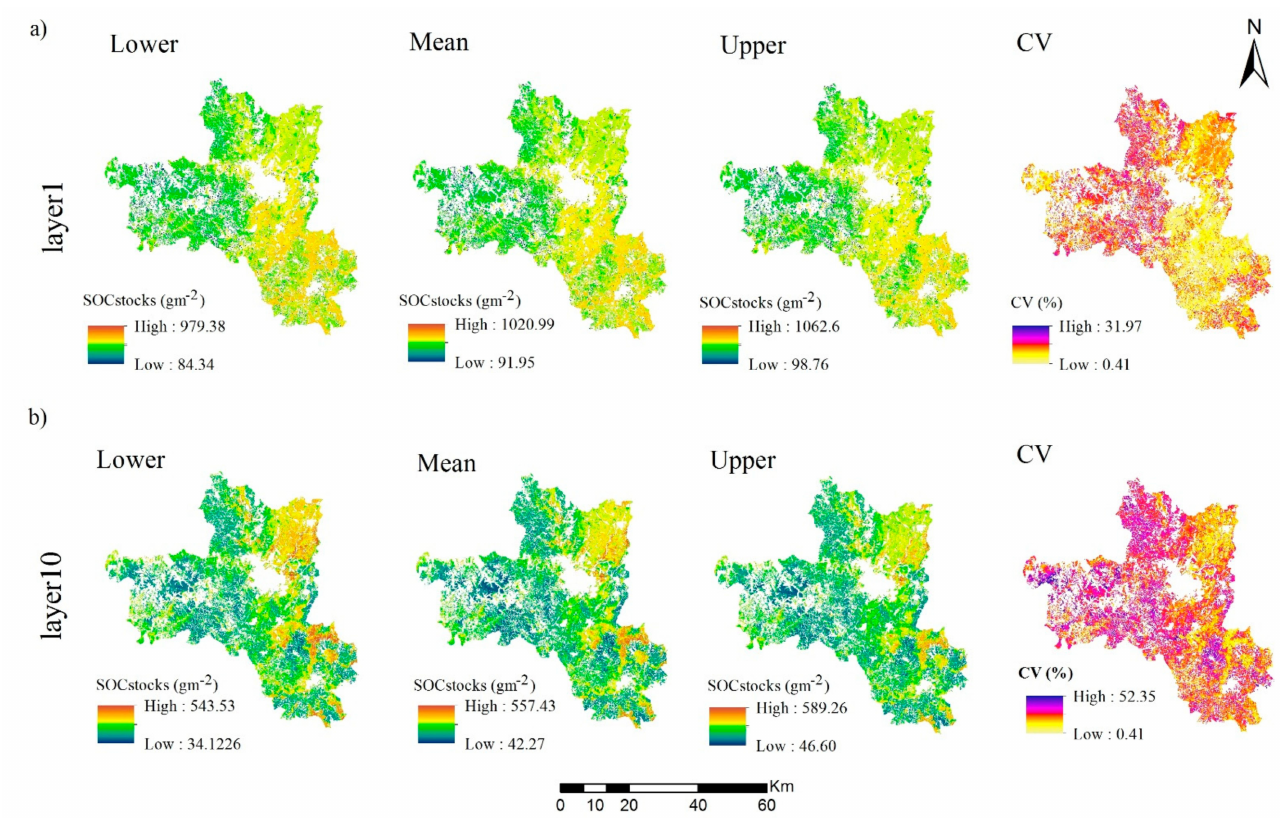
Figure 12. SOC stocks maps for ( a ) layer 1(0–10cm) and ( b ) layer 10 (90–100cm) from bootstrapped (100 runs) Lower, Mean and Upper predicted values and CV (percent of coefficient of